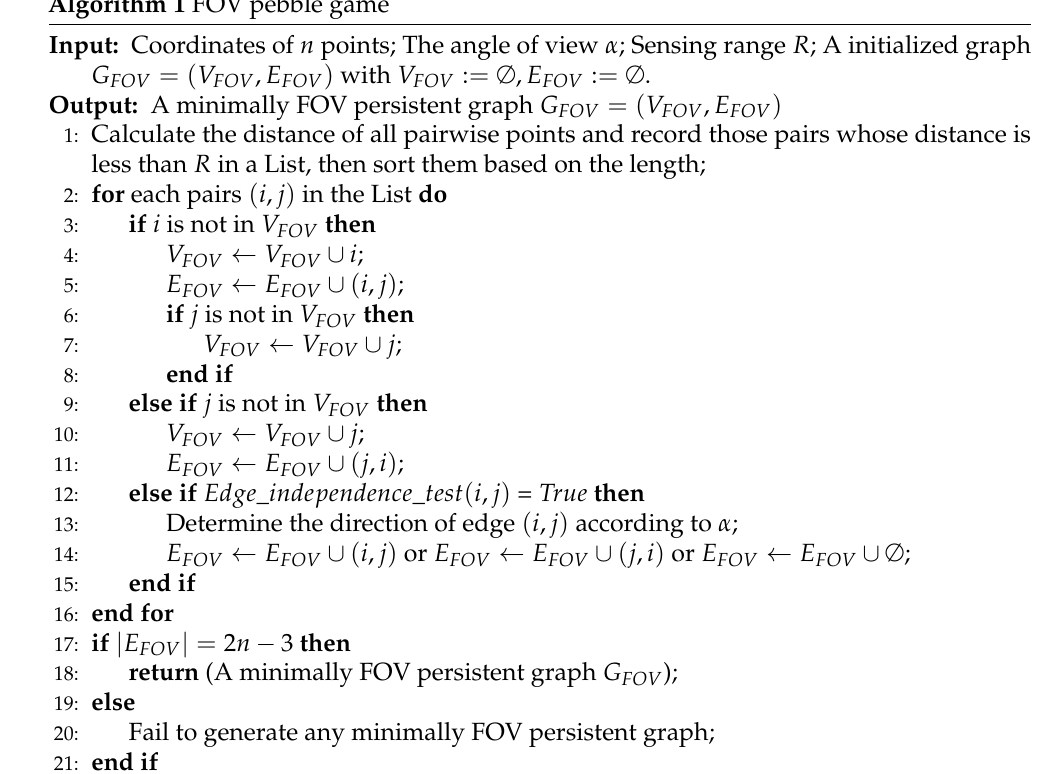
Algorithm 1 FOV pebble